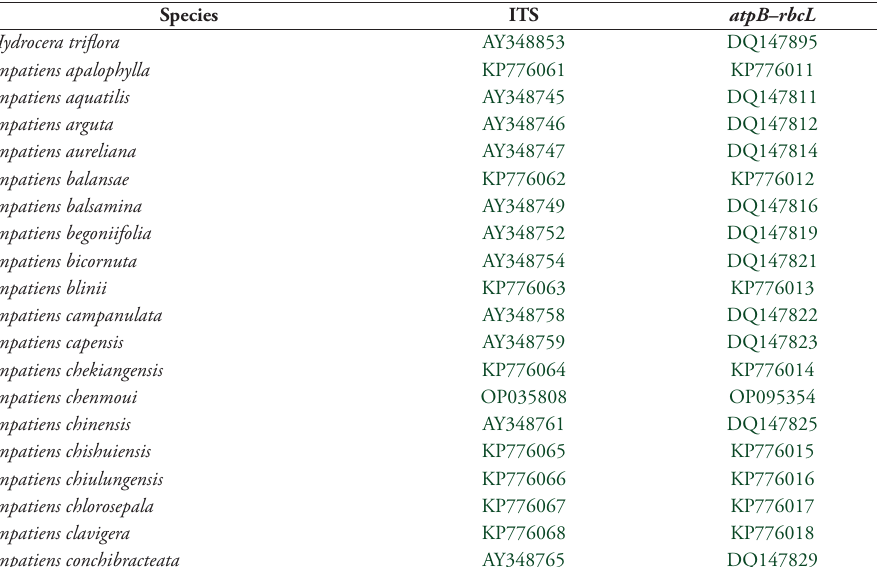
Table A1. Species and sequences sampling list with Genbank accession